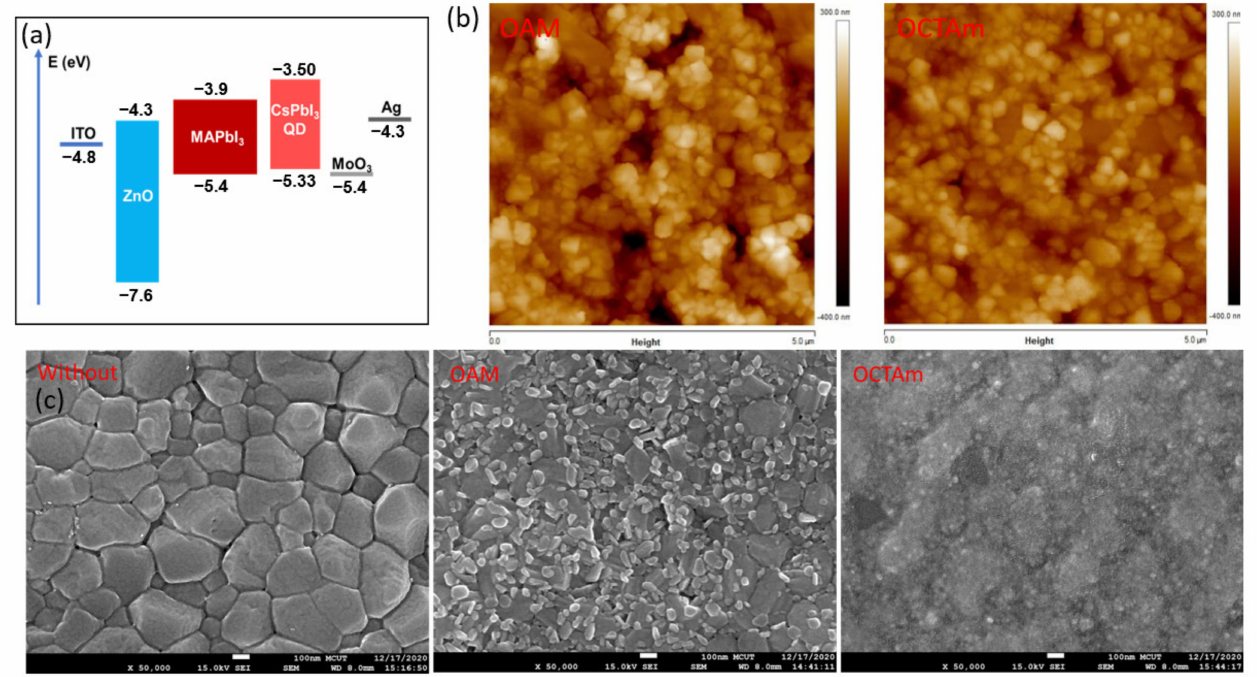
Figure 2. ( a ) The energy level diagram of PSC; ( b ) SEM and ( c ) AFM images of MAPbI 3